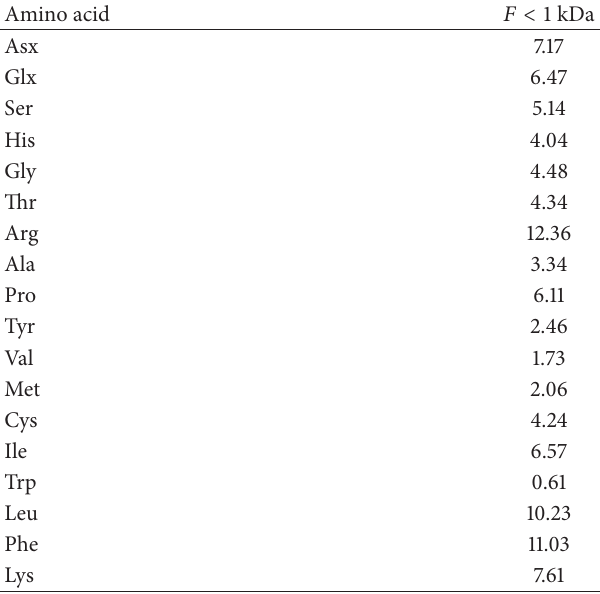
Table 1: Amino acid contents (g/100g) of the < 1kDa ultrafiltered fraction from a S. hispanica protein hydrolysate.